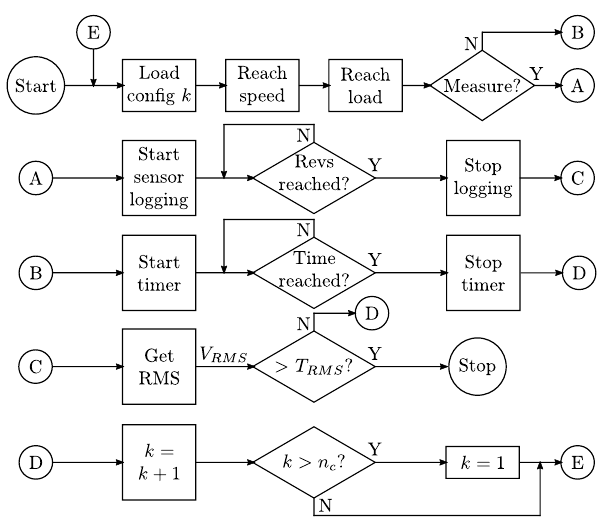
Figure 16: Control scheme for the accelerated